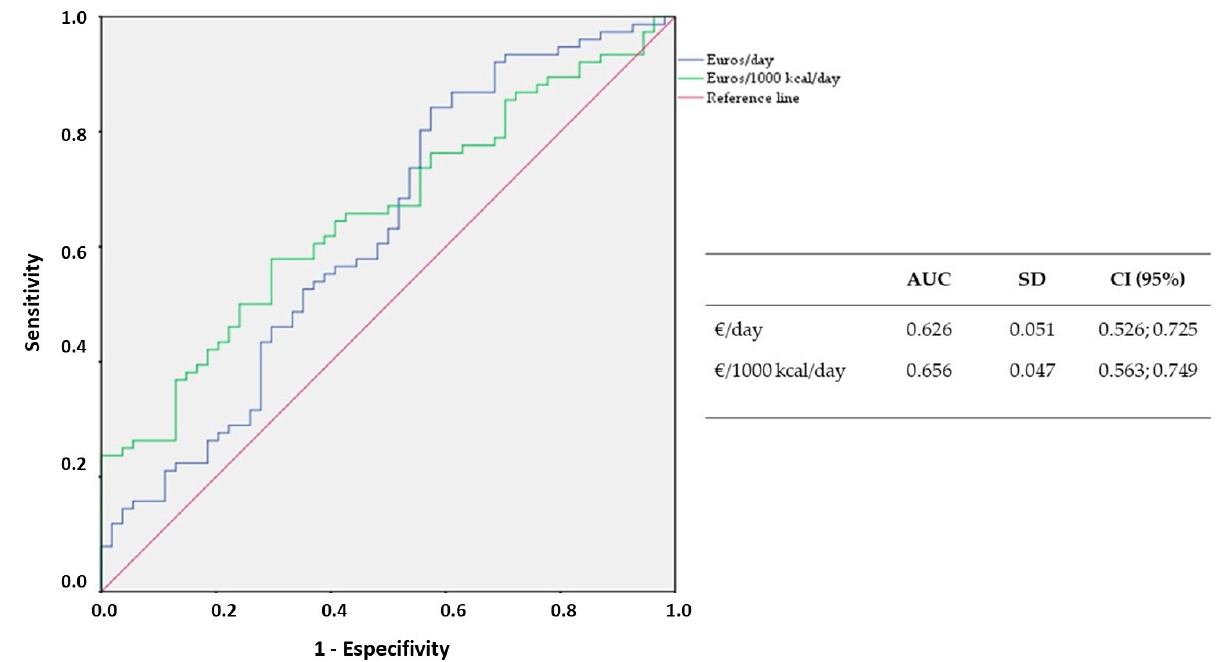
Figure 2. ROC curve of the accuracy of the MD adherence in assessing monetary cost. AUC: Area under the curve. Table 3. Association of monetary cost of diet and adherence to the Mediterranean diet. Standard p B Error